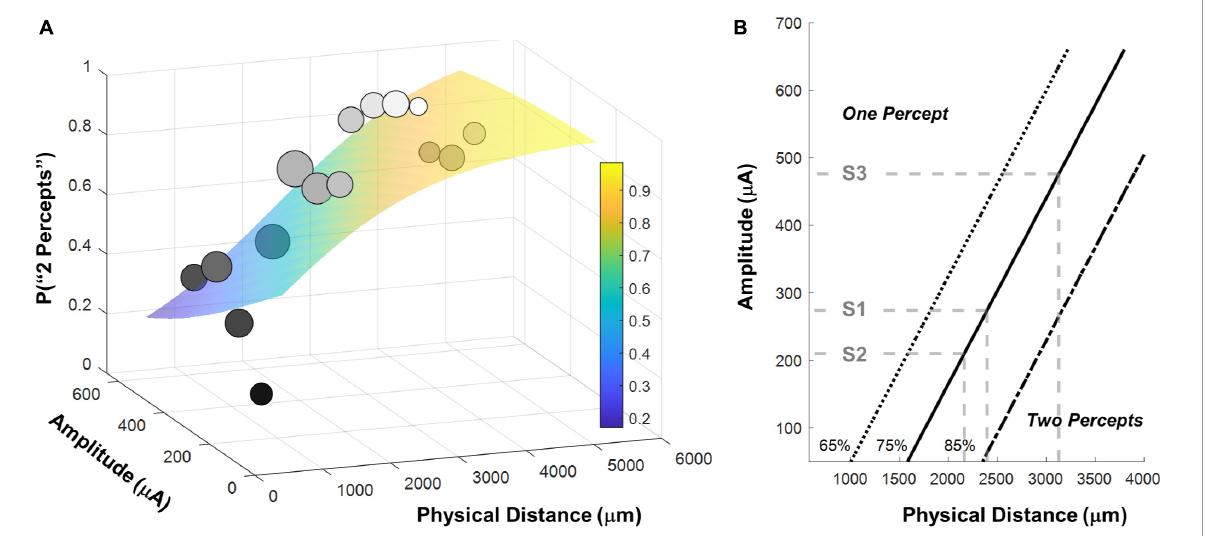
FIGURE6 (A) Surface predicting the probability of reporting 2 percepts using logistic regression with mean detection threshold amplitude and physical distance as fixed factors. Individual data points are generated by binning the data (collapsed across participants) and calculating the probability of seeing two percepts in each bin. The gray-scale shade of the data point represents the probability of seeing two percepts, the size of the data point represents the number of observations in that bin. Surfaces were fit to the original trial-by-trial un-binned data. (B) 65%, 75% and 85% two-point discrimination iso-performance curves as a function of amplitude and physical distance. Gray dashed lines show predicted two-point discrimination thresholds for electrodes at the median current amplitude threshold values for